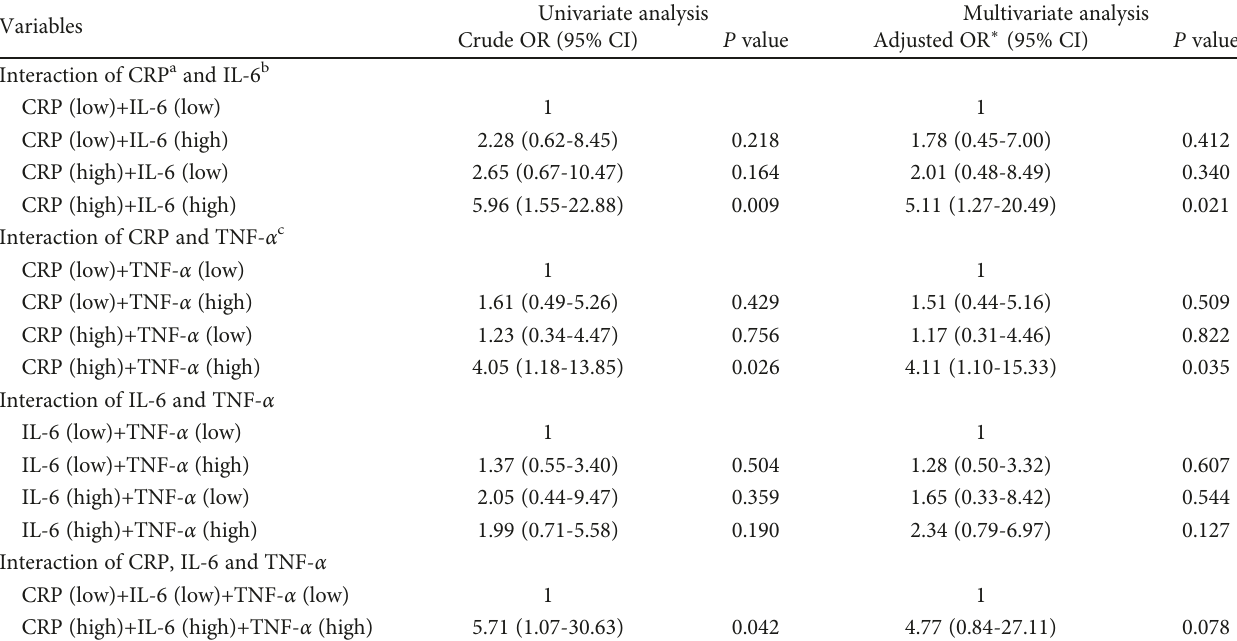
Table 4: Odds ratios (ORs) and 95% con fi dence intervals (CIs) for 2-year progression of type 2 diabetes according to interaction between baseline serum CRP, IL-6, and TNF- α